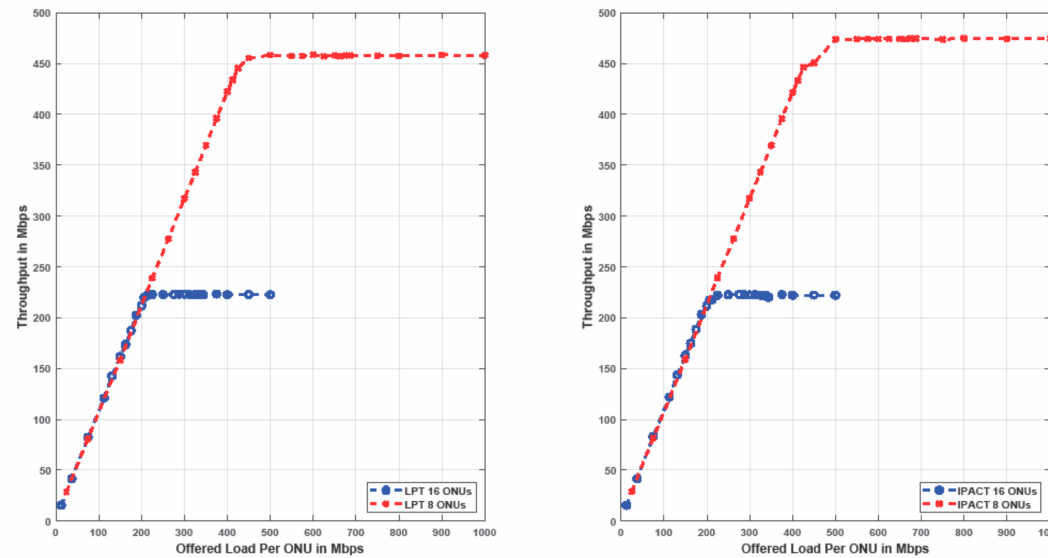
Figure 4. Throughput of all ONUs at LTT = 10 µ s for 16 ONUs vs. 8 ONUs; LPT ( left ) and IPACT ( right